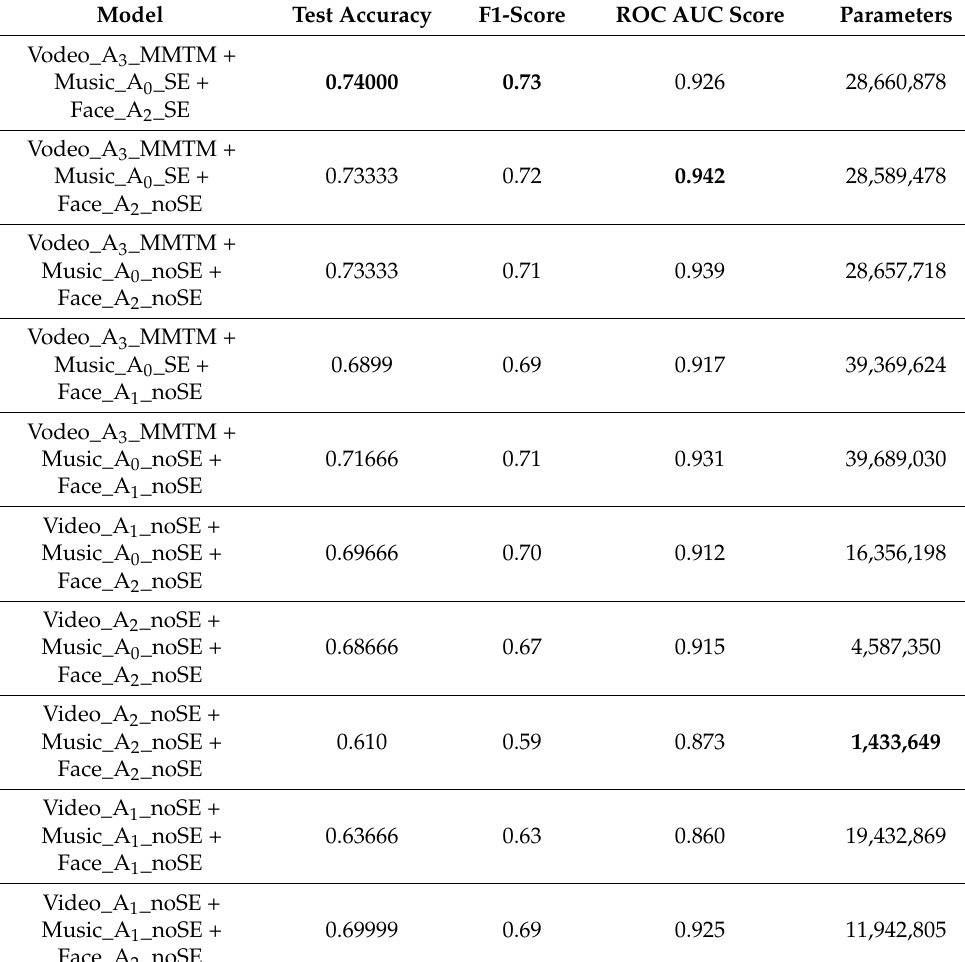
Table 6. Integrated test results using music, video, and facial